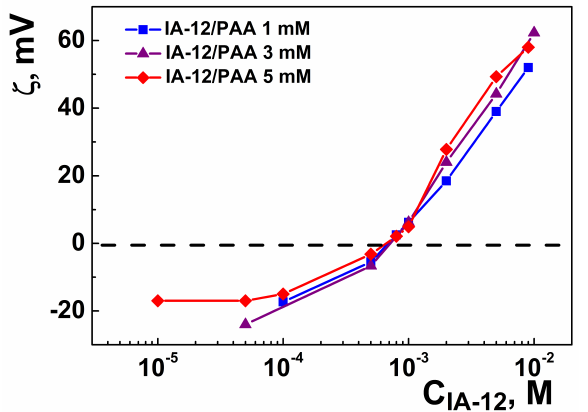
Figure 4. Zeta potential versus IA-12 concentration plot for the IA-12/PAA binary systems; 25 ◦ C.